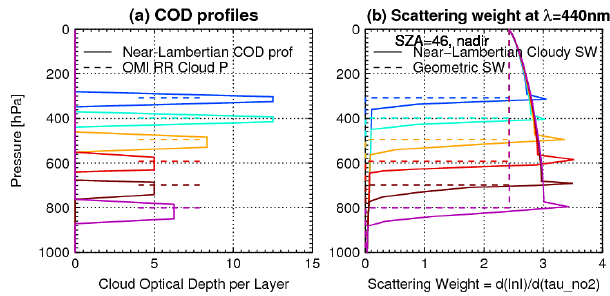
Figure 3. (a) Near-Lambertian COD profiles (solid lines) that corre- spond to various cloud OCPs (dashed lines), (b) scattering weights calculated using near-Lambertian COD profiles (solid lines) accom- panied by geometric weighting functions (dashed